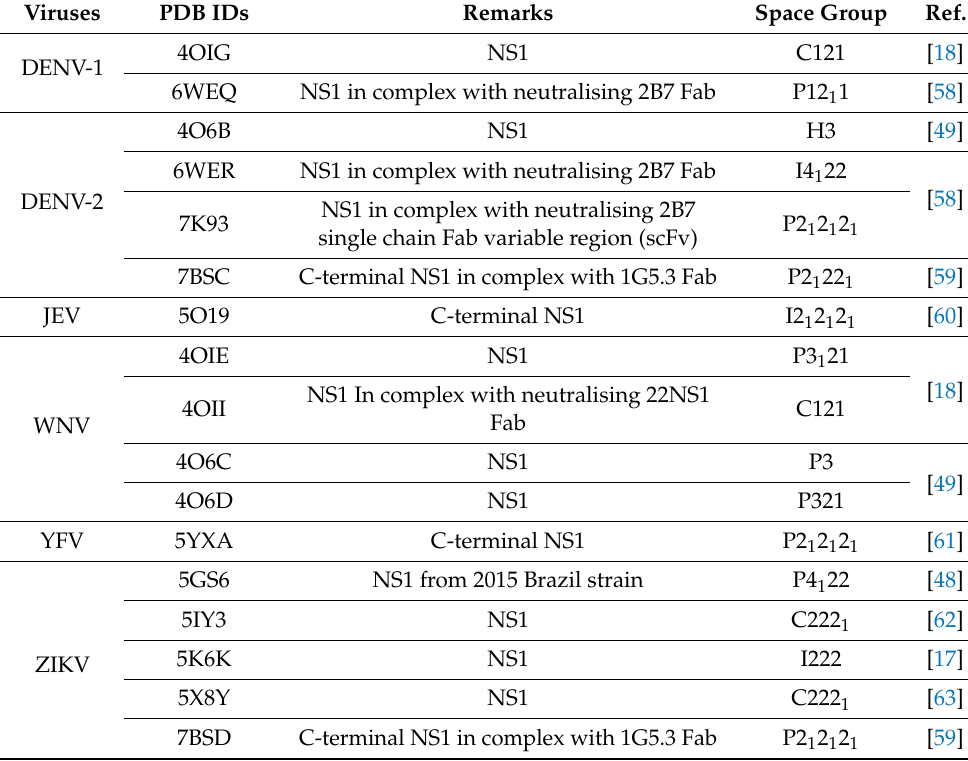
Table 1. A summary of the protein structures of the NS1 proteins published in the Protein Data Bank. Viruses PDB